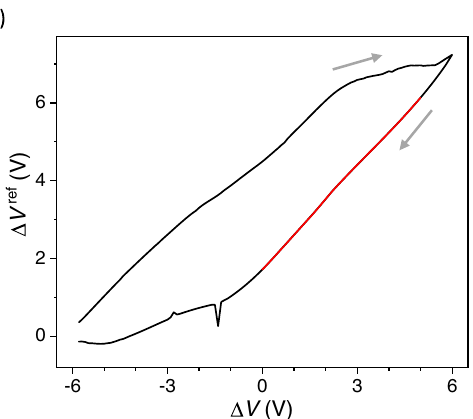
4Ldevicesrepresentthe fi eldvaluesfromestimatedreferencevoltage, Δ V ref = α Δ V , for the respective devices. The red-shaded region from 0.1 to 0.3V/nm shows the maximum fi eld strength in conventional dielectric devices. The cartoon inset illustrates the relation between the potential difference of top/bottom ILs and the fi eld across the device, F ⊥ = Δ V ref / d ⊥